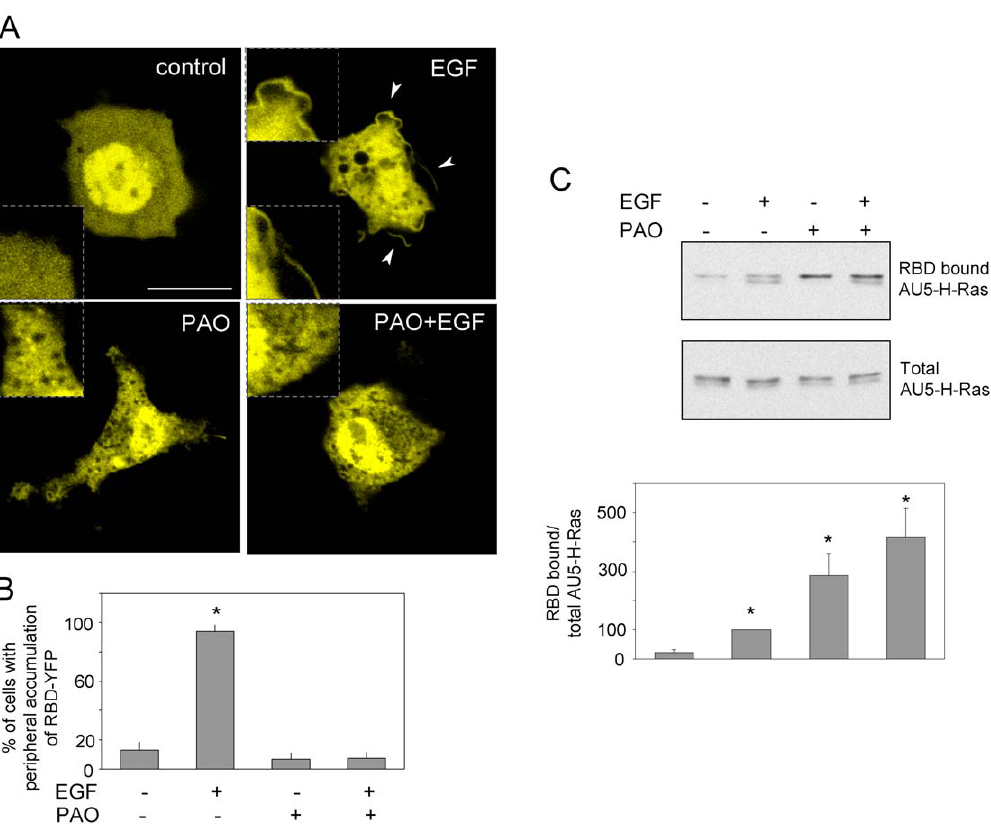
Figure 6. Effect of PAO on Ras activation. (A) COS-7 cells were transfected with YFP-RBD, serum starved for 16 h and pre-incubated with vehicle or 1 m M PAO for 1 h before stimulation with 100 nM EGF. Cells were visualized live by confocal fluorescence microscopy. Shown are representative images from at least five experiments with similar results. Dotted inserts show enlarged areas from the same cells for better visualization. Arrowheads mark the accumulation of YFP-RBD at defined locations of the cell periphery. Bar, 20 m m. At least 40 cells were monitored per experimental condition and the percentage of cells showing accumulations of YFP-RBD at the cell periphery is shown in (B) as average values 6 standard error of mean (SEM) of five independent experiments. (C) Cells were treated as above and cell lysates were subjected to pull-down on GST-RBD beads for collection of Ras in its active conformation. Levels of RBD-bound and total AU5-H-Ras were assessed by western blot. Results shown are representative of three assays. The lower panel presents the quantitation of RBD-bound AU5-H-Ras/total AU5-H-Ras ratios from three independent experiments as average values 6 SEM. *p , 0.05 vs vehicle.